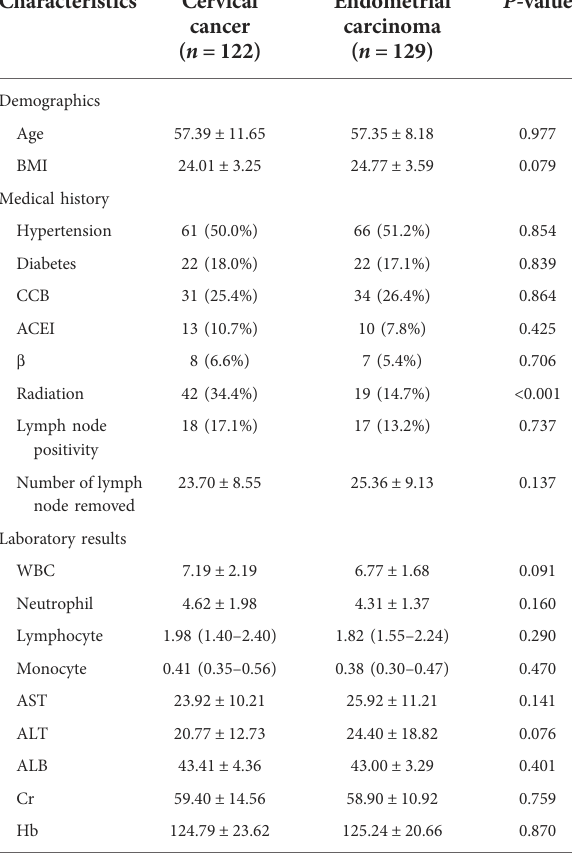
TABLE 2 Patients ’